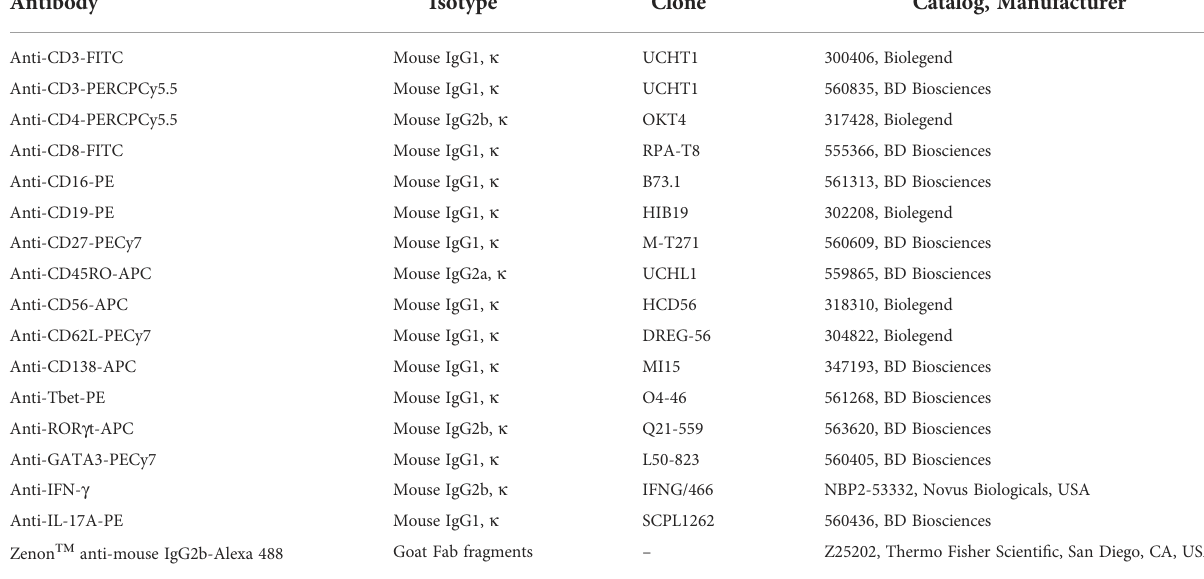
TABLE 1 List of antibodies used for